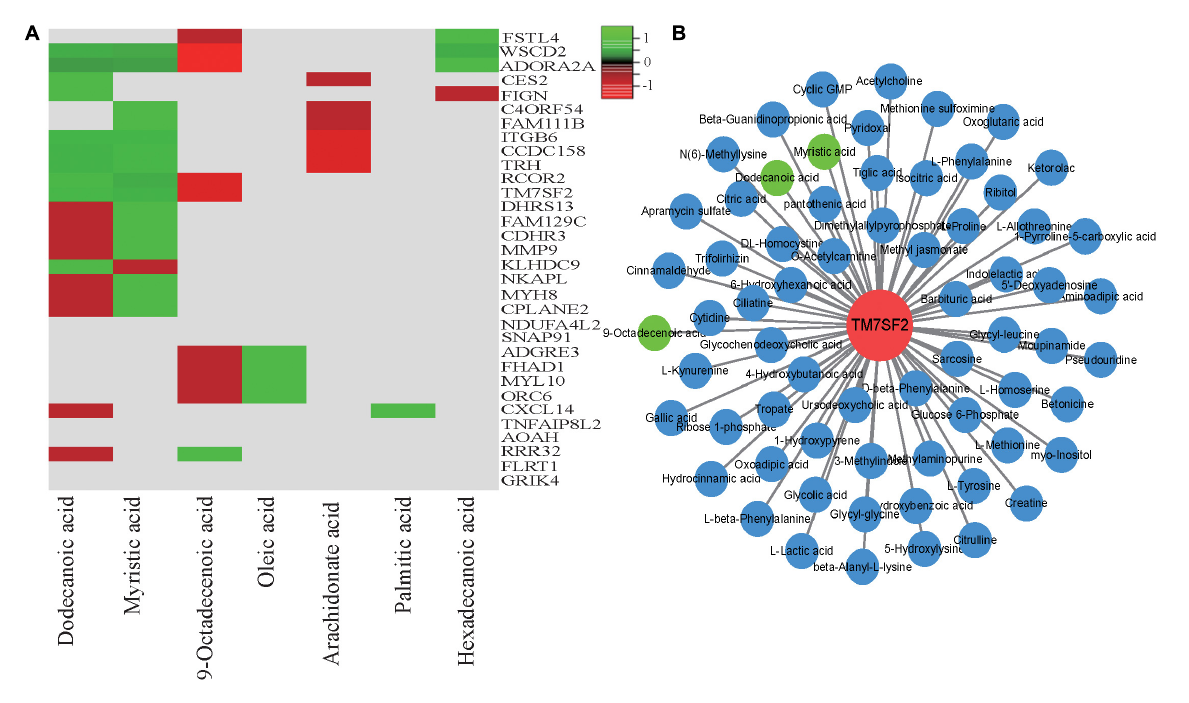
FIGURE7 Correlation and pathway analysis of significant differential compounds and verification of the associated DEGs. (A) Correlation analysis of the significant differential metabolites and the DEGs; (B) Cytoscape representation of candidate gene TM7SF2 and co-expressed differential metabolites involved in lipid metabolism. Hub gene TM7SF2 is in red; related differential metabolites are in blue circles, and the three trait-related metabolites are in green.